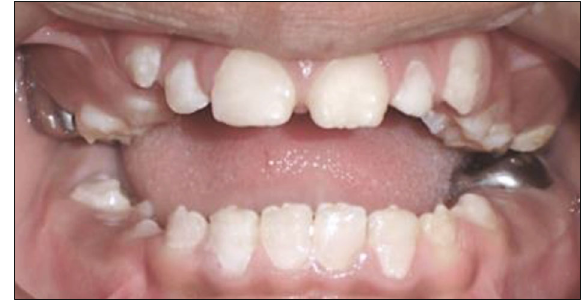
Figure 5: Intraoral front.